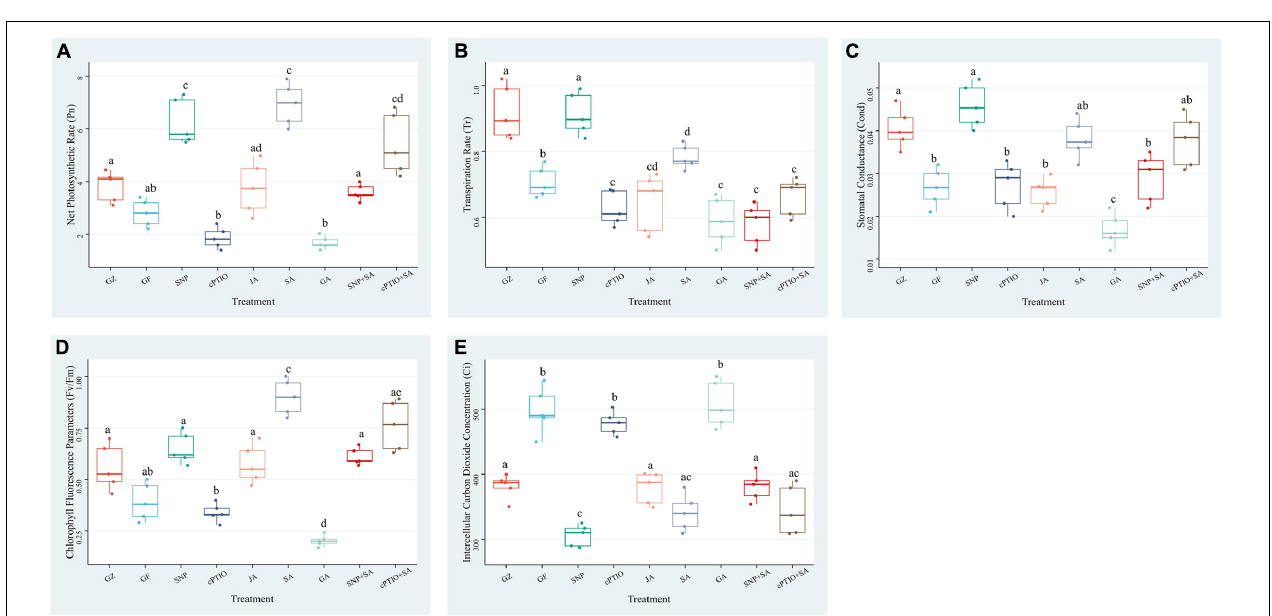
concentration (Ci) showed a significant increase of